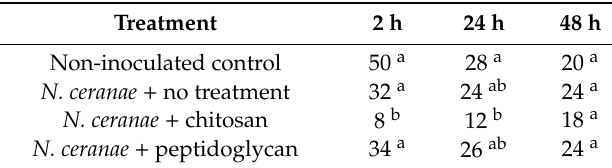
Table 2. Percentage of bees that showed positive proboscis extension reflex (PER) at 2, 24, and 48 h. The bees were either non-inoculated with N. ceranae , inoculated with 1 × 10 5 spores of N. ceranae only ( N. ceranae + no treatment), N. ceranae and 1.0 µ g / µ L chitosan ( N. ceranae + chitosan), and 1.0 µ g / µ L peptidoglycan ( N. ceranae + peptidoglycan) (n = 50 per treatment). Treatment 2 h 24 h 48 h Non-inoculated control 50